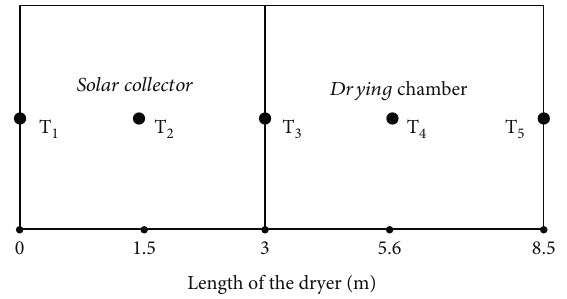
Figure 3: Positions where the temperature is taken (side